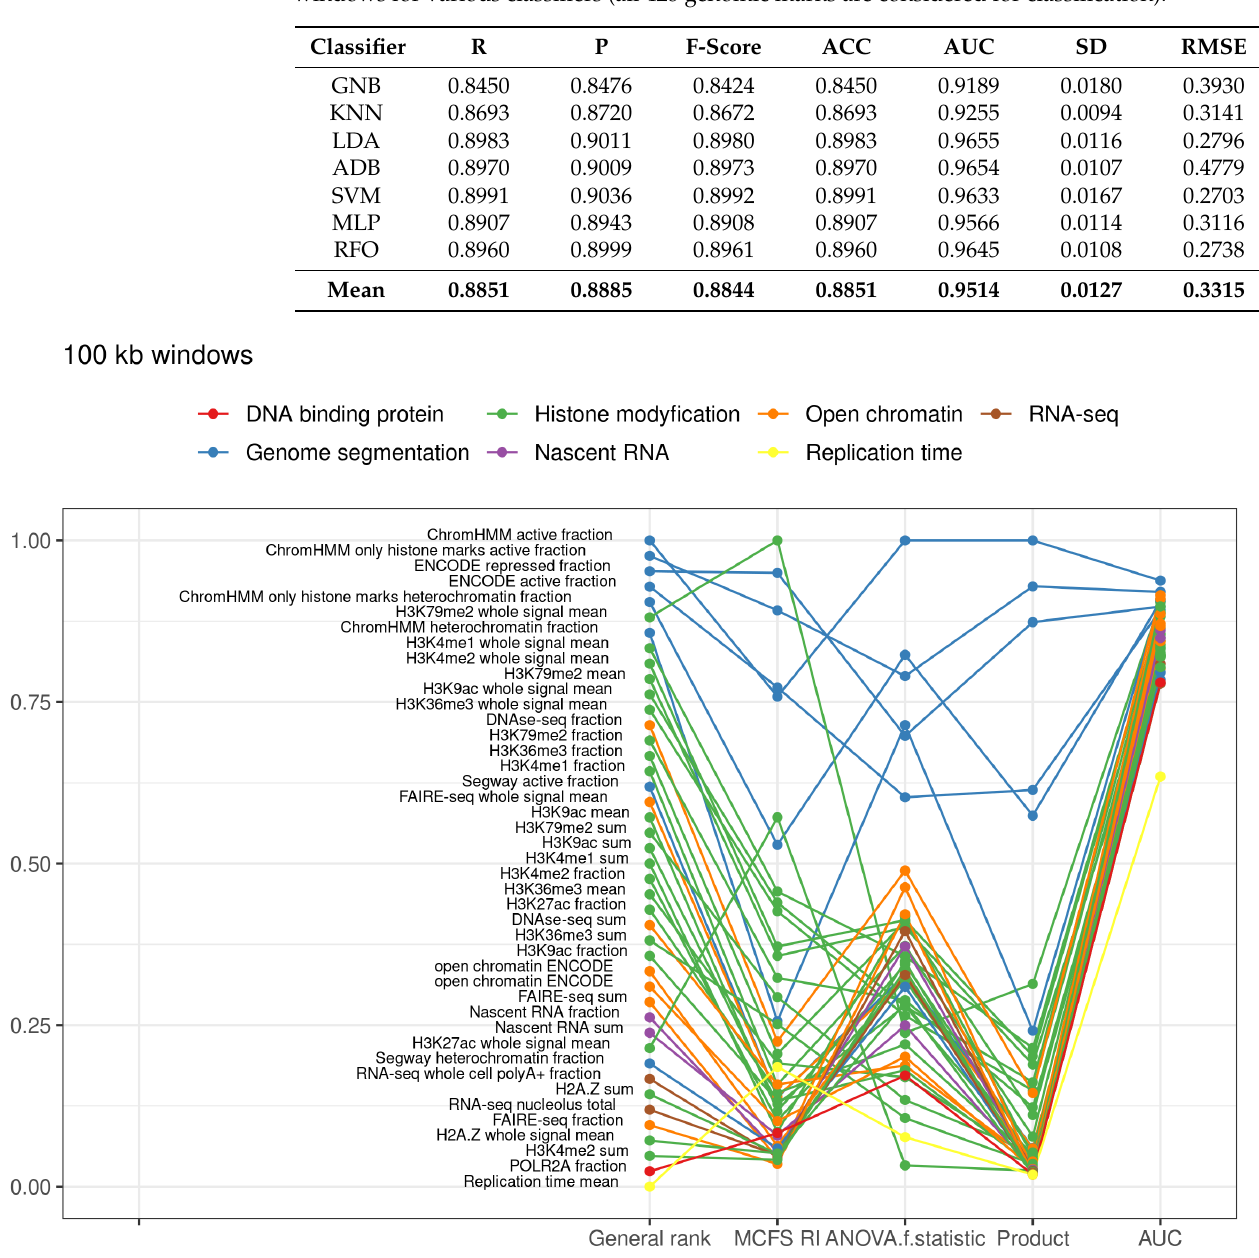
Figure 5. Top decile of the most important features for classification of 100 kb windows into